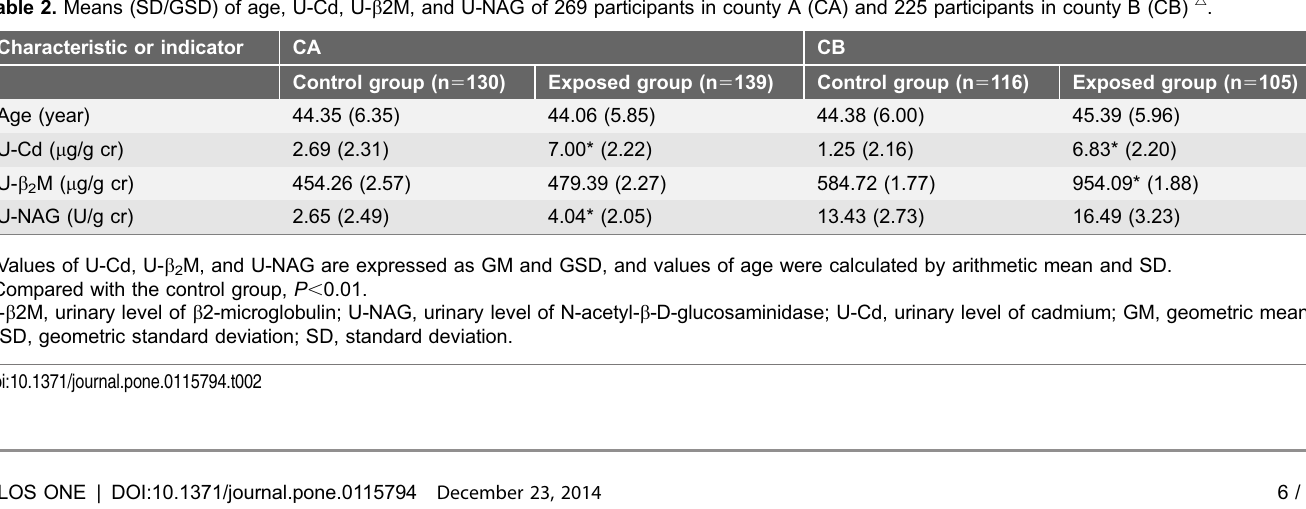
Table 2. Means (SD/GSD) of age, U-Cd, U- b 2M, and U-NAG of 269 participants in county A (CA) and 225 participants in county B (CB) g . Characteristic or indicator